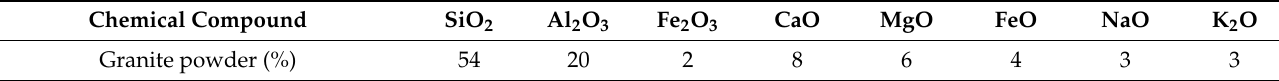
Table 2. Chemical composition of the used granite powder (%).